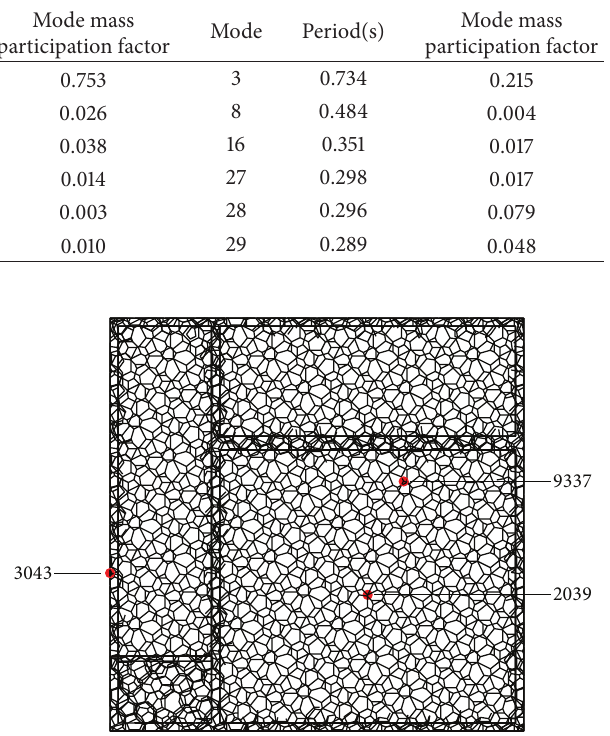
Figure 2: The displacement peak